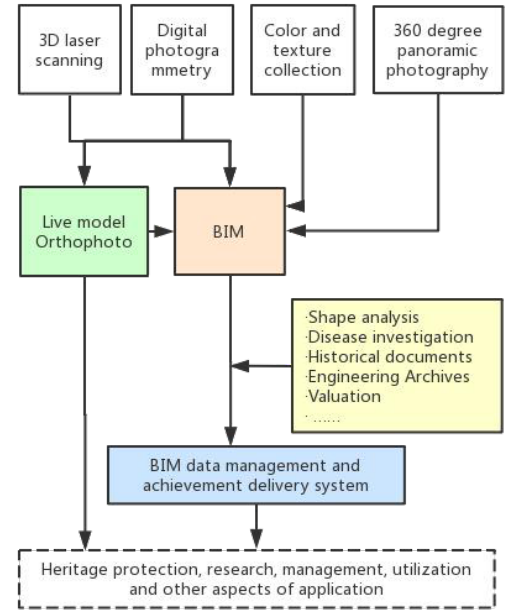
Figure 2. Technical route of HBIM proposed by the authors